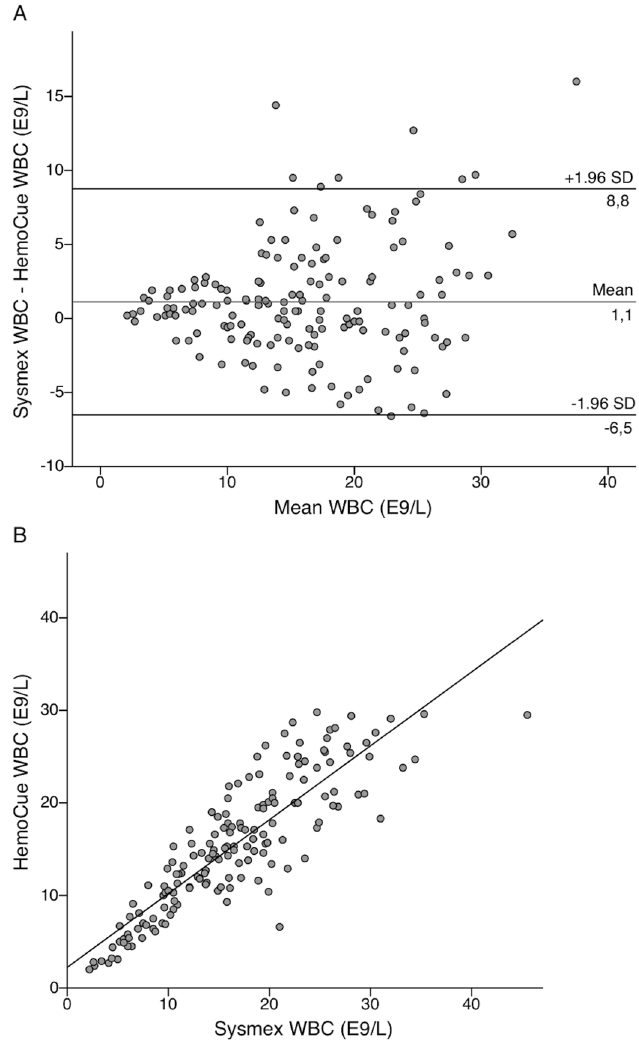
Fig 3. Bland-Altman and linear correlation plots for comparison of WBC methods in the emergency department. Bland-Altman plot presenting level of agreement (A) and a scatterplot showing linear correlation (B) between the HemoCue white blood cell (WBC) point-of-care (POC) test and Sysmex WBC results in 171 pediatric emergency department (ED) visits. Clinicians performed POC testing at the ED in capillary blood samples and Sysmex analysis was done in venous blood samples in the